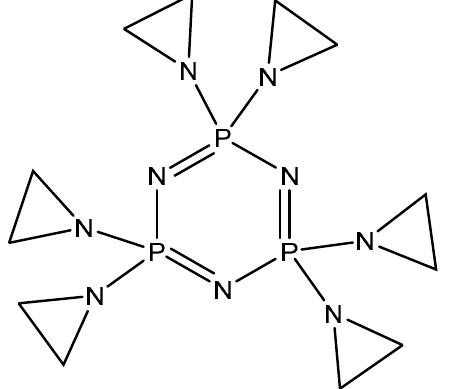
Figure 11. TGA traces of (a) neat polyimide, (b) PI-PDMS block copolymer, (c) PI-Phosphazene co- polymer, and (d) neat phosphazene in air atmosphere [57,136]. copolymer, and (d) neat phosphazene in air atmosphere